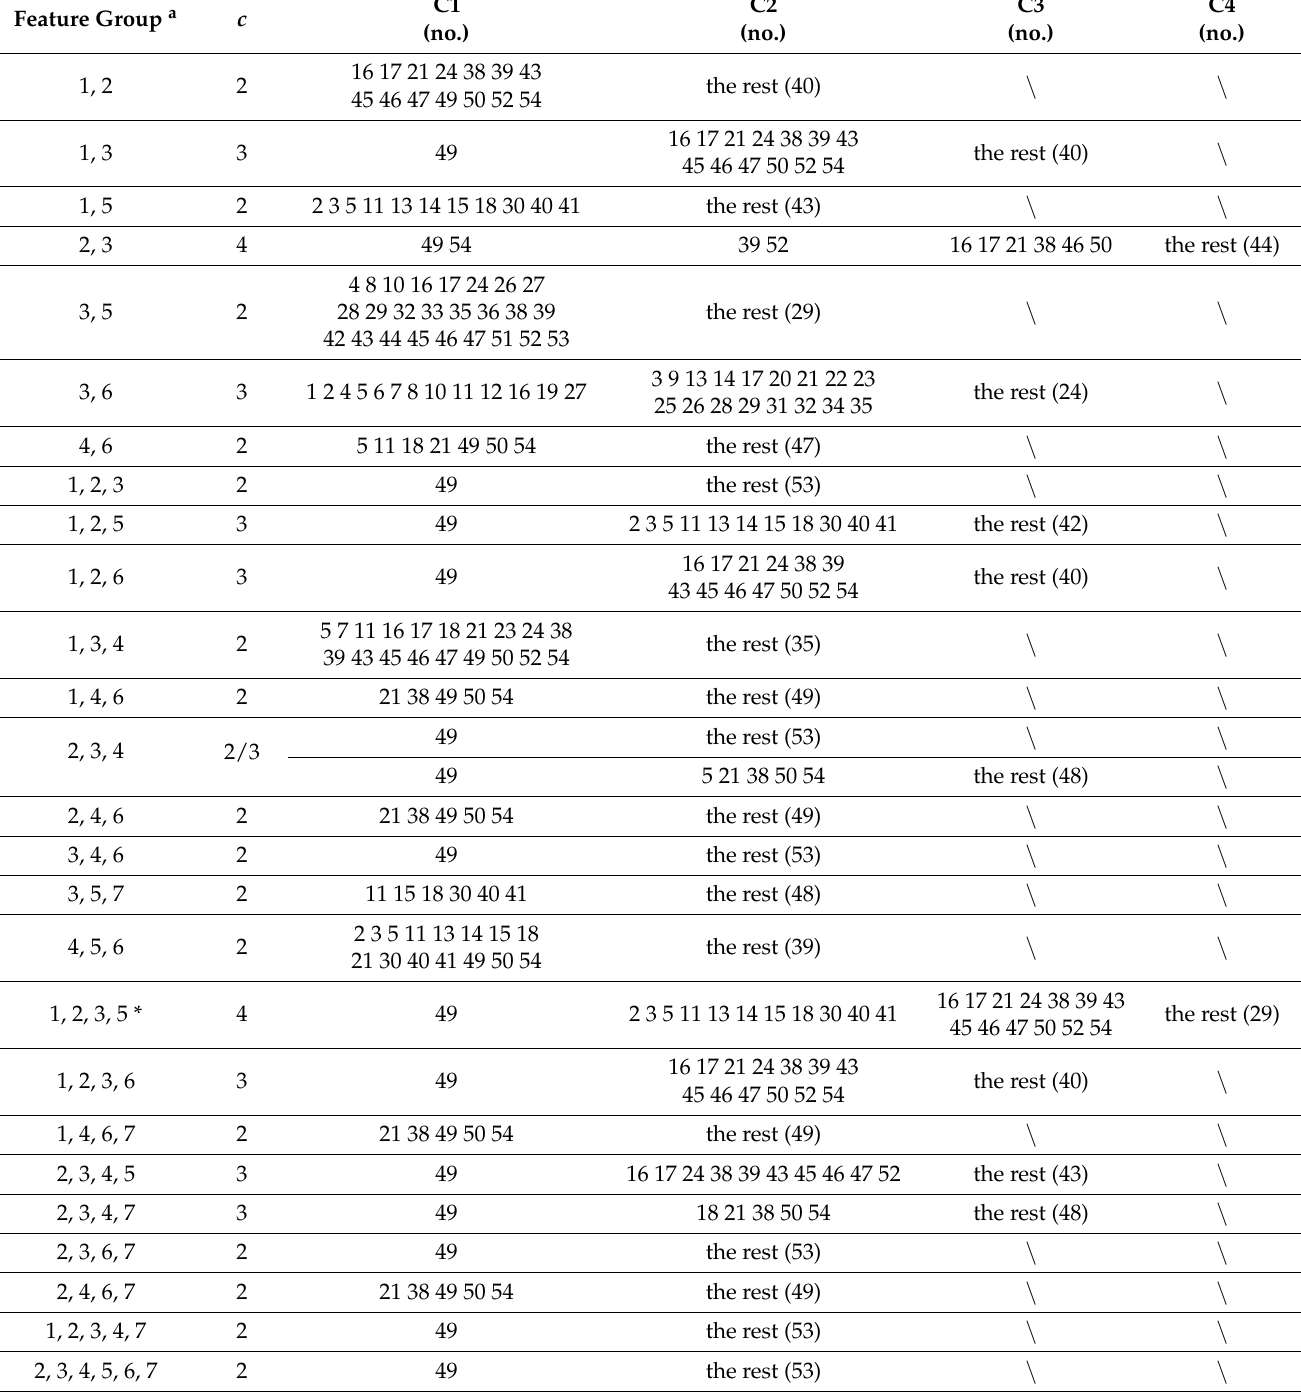
Table 2. Clustering statistics of different feature groups with the cluster number c ≥